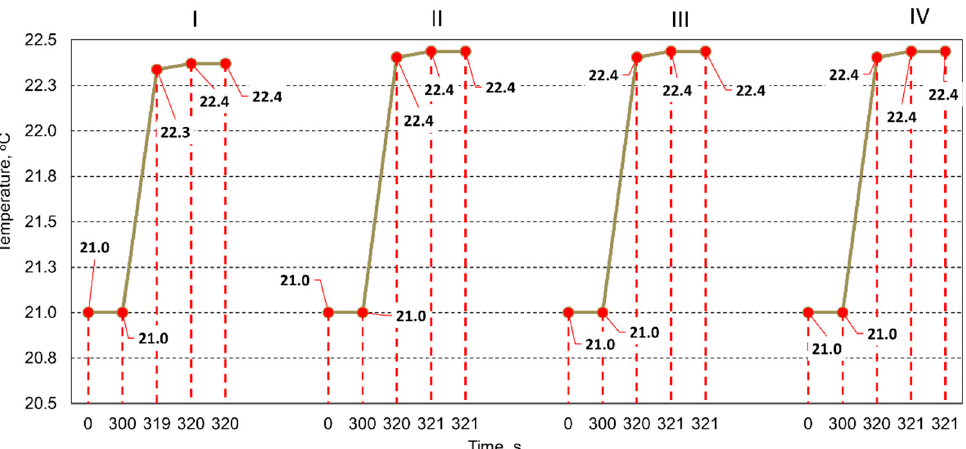
Figure 14. Characteristics of combustion temperature of a larch tree sample conditioned with a pulsed electric field: I (electric field intensity 25 kV · cm − 1 and number of pulses 150); II (electric field intensity 25 kV · cm − 1 and number of pulses 300); III (electric field intensity 30 kV · cm − 1 and number of pulses 150); IV (electric field intensity 30 kV · cm − 1 and number of pulses 300).